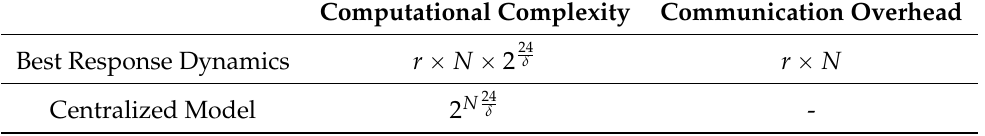
Table 1. Computational complexity and communication overhead of the best response algorithm if compared to the centralized model (worst-case